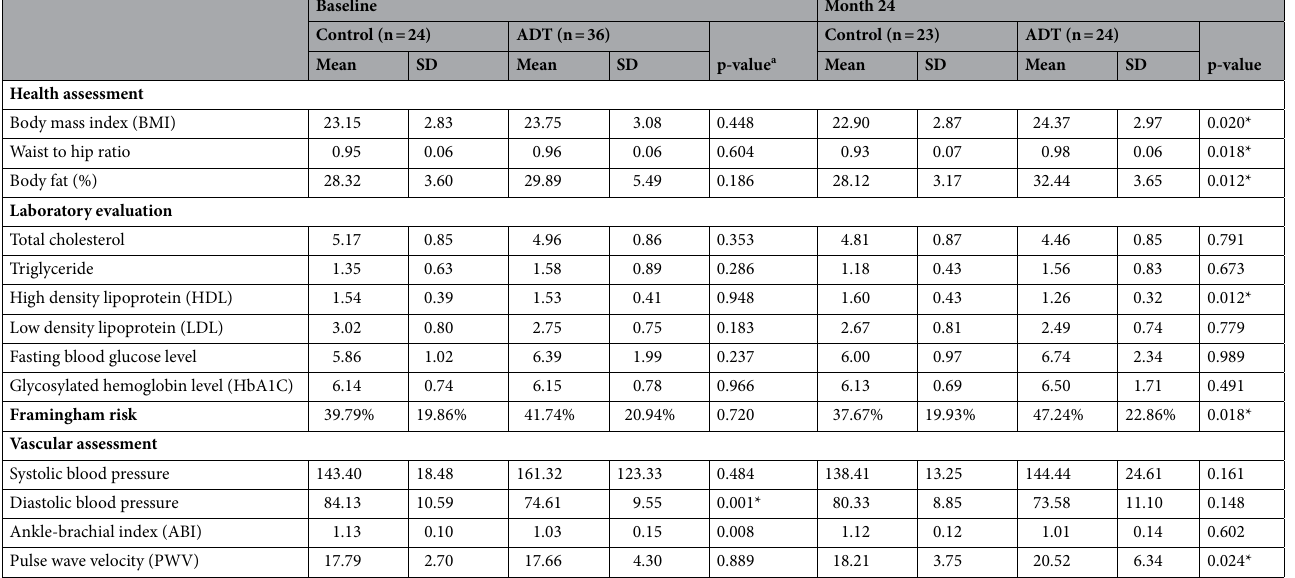
Table 3. Between group